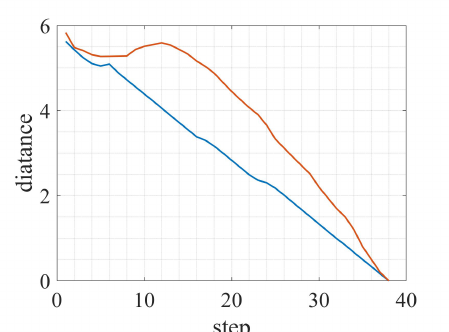
Figure 16. The changes of the distance between the robot and the target point using the proposed DIAPF method (blue) and ROS path plan module